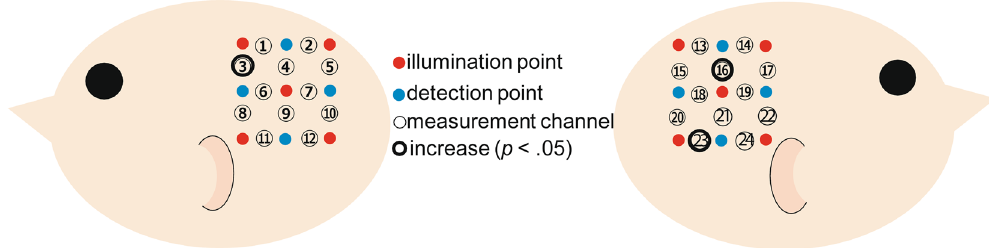
Figure 3. Locations of the measurement channels in the current study. The probes for infants were placed on the right and left temporal regions centered at the T5 and T6 position of the international 10–20 system. The blue circles represent for detector, and the red circles represent for emitter. Each number correspond to the measurement